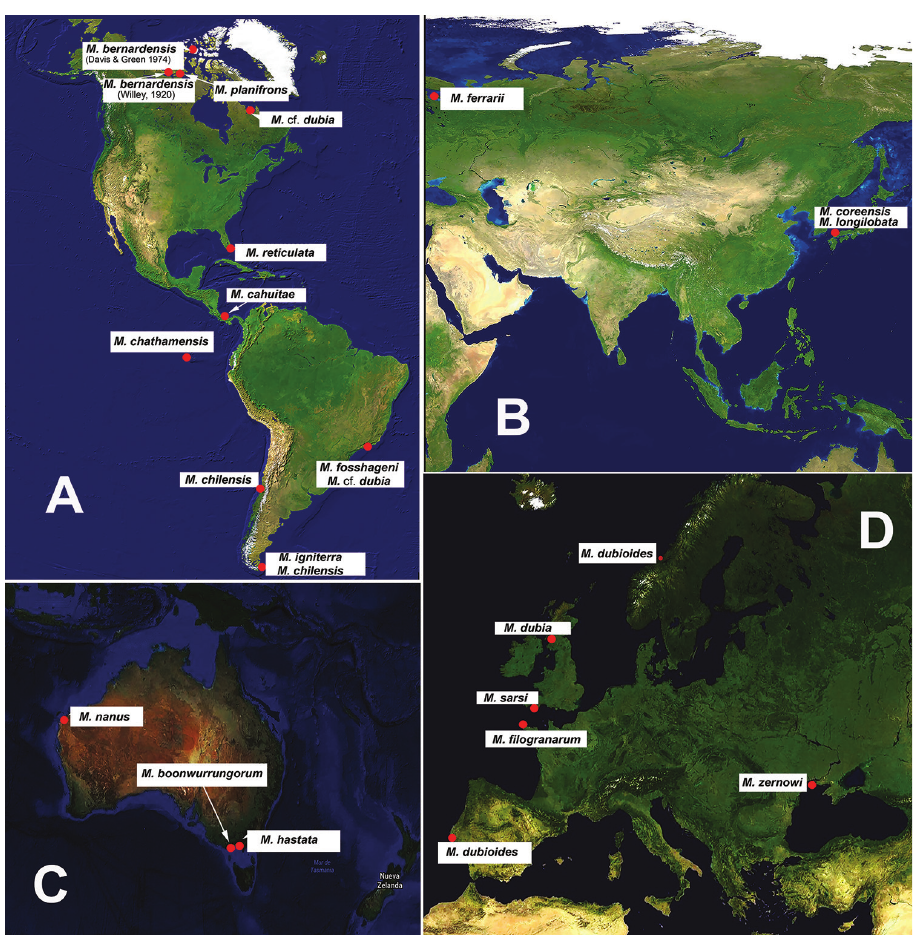
Figure 5. Worldwide distribution of species of Monstrillopsis (Scott 1904; Dolgopolskaya 1948; Davis 1949; Fontaine 1955; Suárez-Morales and Dias 2001; Suárez-Morales and Ivanenko 2004; Suárez-Mo- rales et al. 2006, 2008; Suárez-Morales and Morales-Ramírez 2009; Suárez-Morales and McKinnon 2014; Lee et al. 2016). Only confirmed records are shown; there are no records of the genus in Africa. A America B Asia C Australia D